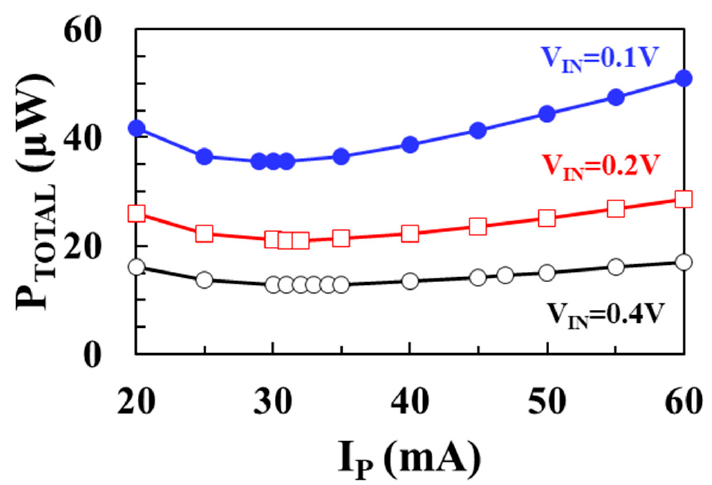
Figure 10. Modeled total loss according to peak inductor current for different input voltages.